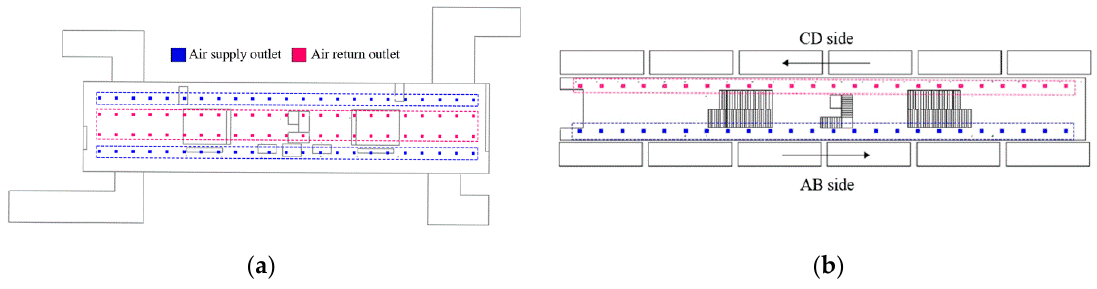
Figure 4. Arrangements of supply and return air outlets in the two floors: ( a ) The concourse floor; ( b ) The platform